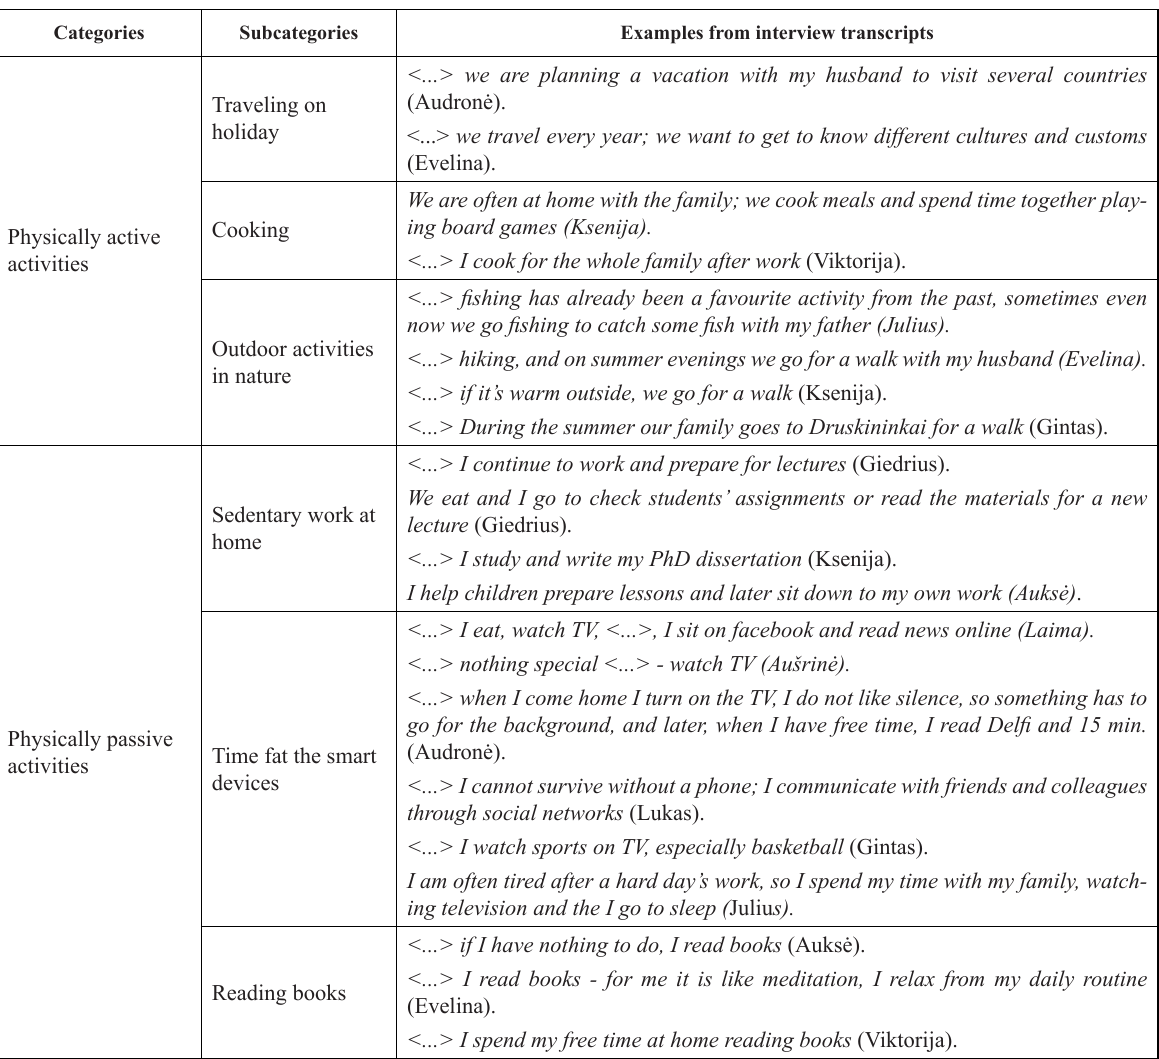
Table 3. Activities od sedentary adults outside working hours